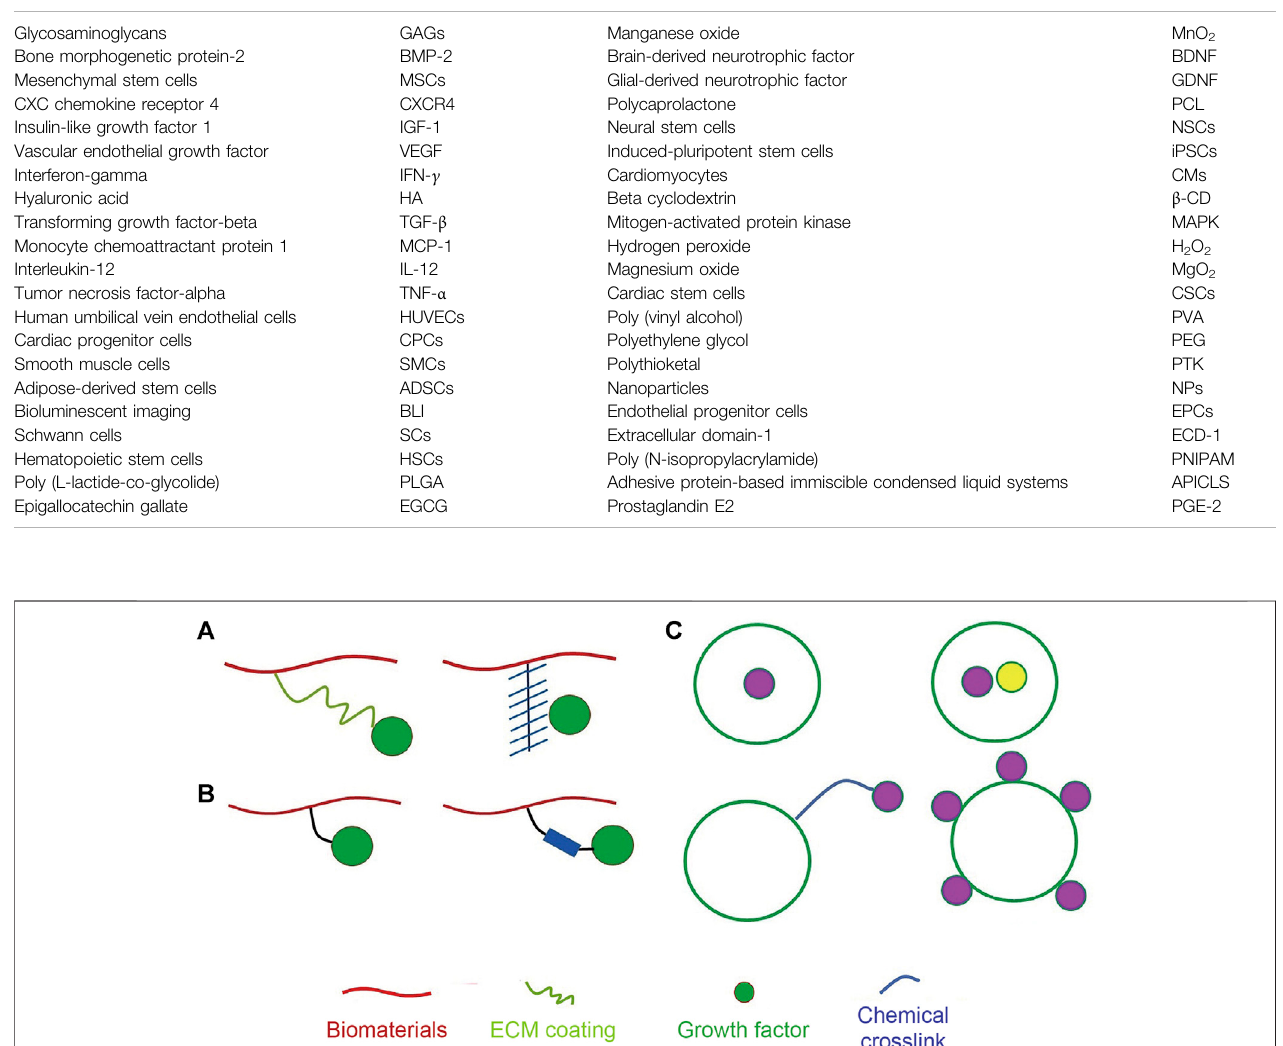
Frontiers in Cell and Developmental Biology |